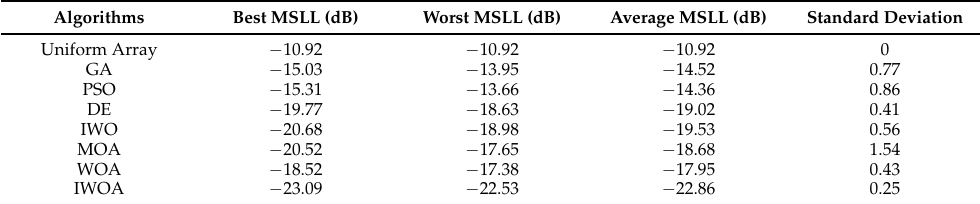
Table 5. Simulation results obtained by IWOA and other optimization algorithms.